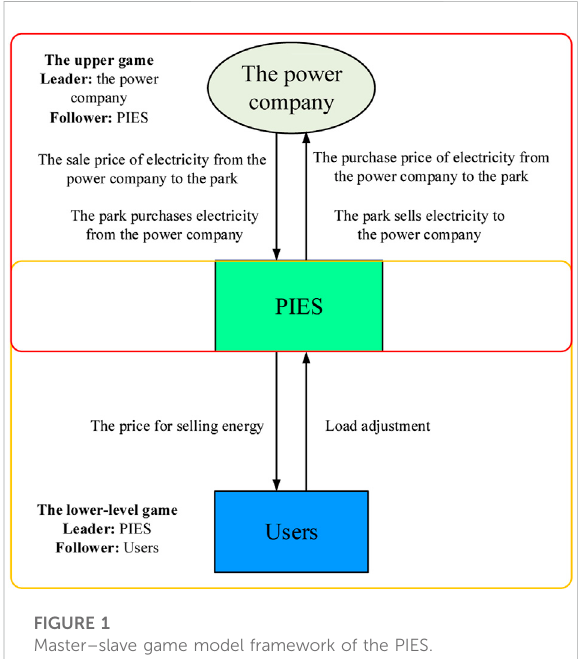
FIGURE 1 Master – slave game model framework of the